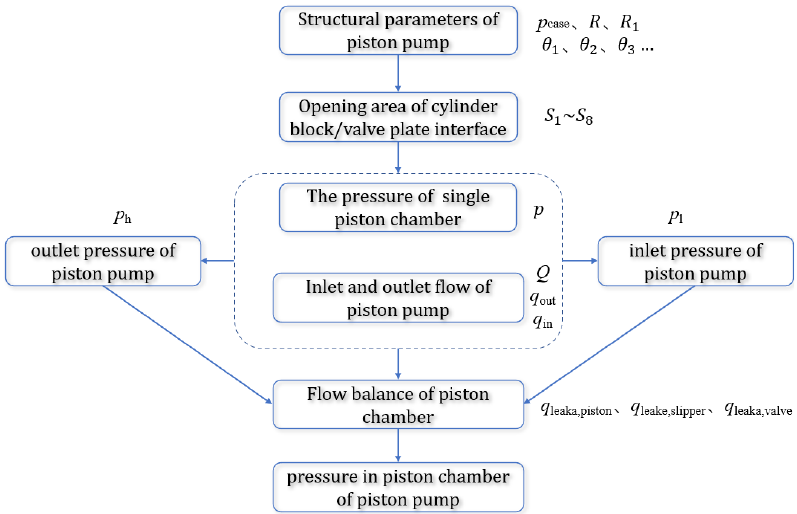
Figure 7. Flow chart of solving pressure fluctuation model of the piston chamber.